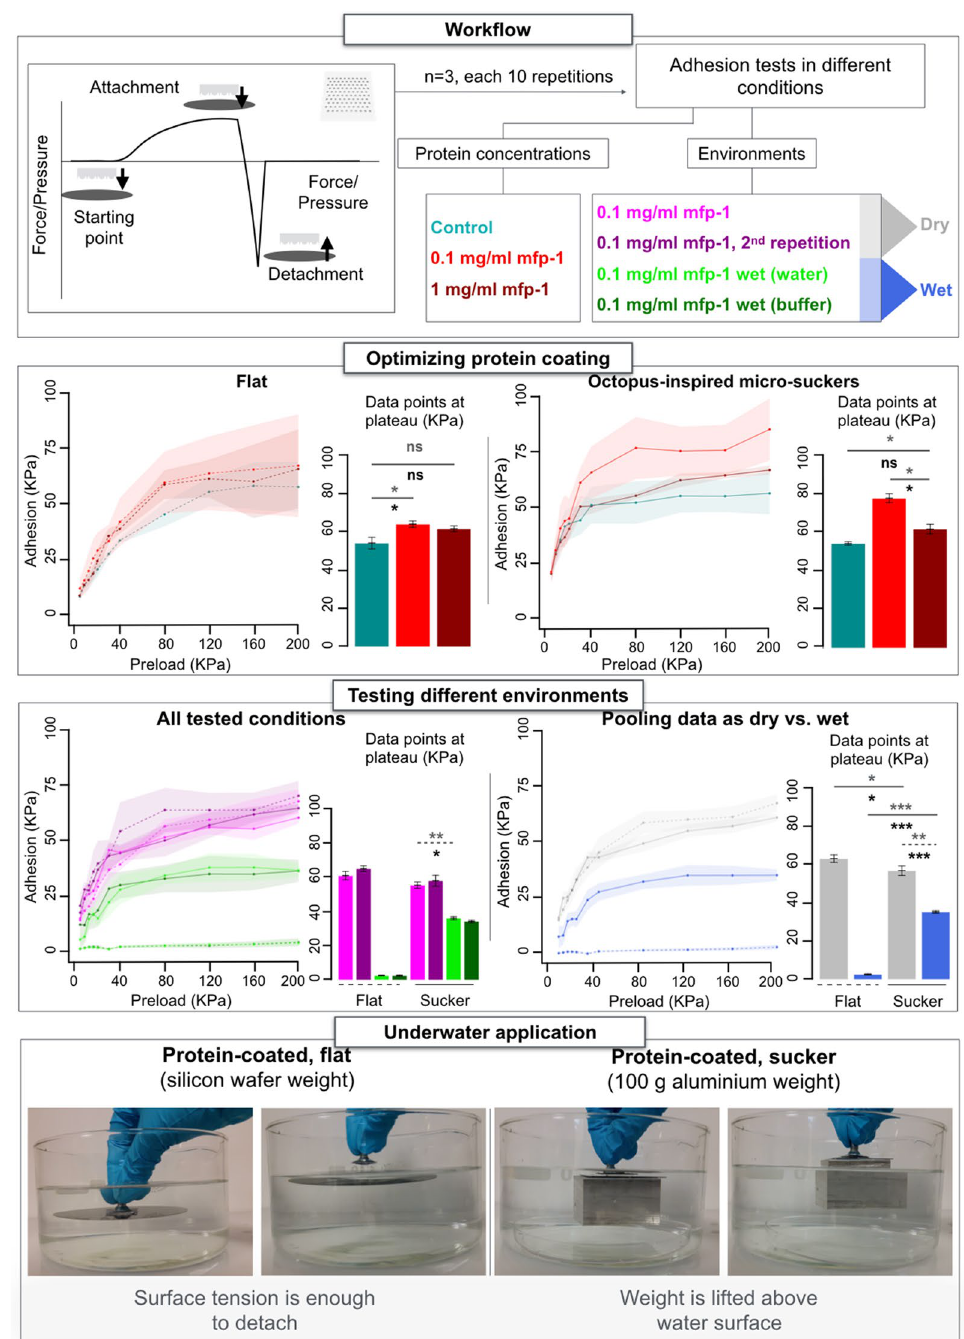
Figure 2. Adhesion tests in different conditions. The top-left box contains a simplistic force vs. time diagram, in which the detachment moment corresponds to the adhesion force; all tested conditions are listed, each one represented with different colors. Each condition was tested using three different samples (n = 3), and every sample was tested for ten repetitions. For line charts, dashed curves are used for control experimental classes with flat surfaces. Solid curves mark experimental classes with octopus-inspired micro-suckers. Data dispersions, visualized as ribbons, report standard error of the mean. Bar charts feature averages of the four data points at the right-end (i.e. at plateau) of every curve. The number of asterisks specifies the significance level for different p-value thresholds (ns—i.e. non-significant—for p > 0.05, *for p < 0.05, **for p < 0.01, ***for p < 0.001); solid lines indicate unpaired two-tailed t-test, and dashed lines paired two-tailed t-test. Line ends indicate the two bars compared in each test. Gray asterisks are used for t-tests, and black asterisks for two-tailed Mann– Whitney U-tests; error bars report standard error of the mean. The bottom box represents the underwater application. Images are screenshots from the demonstrative Supplementary Video